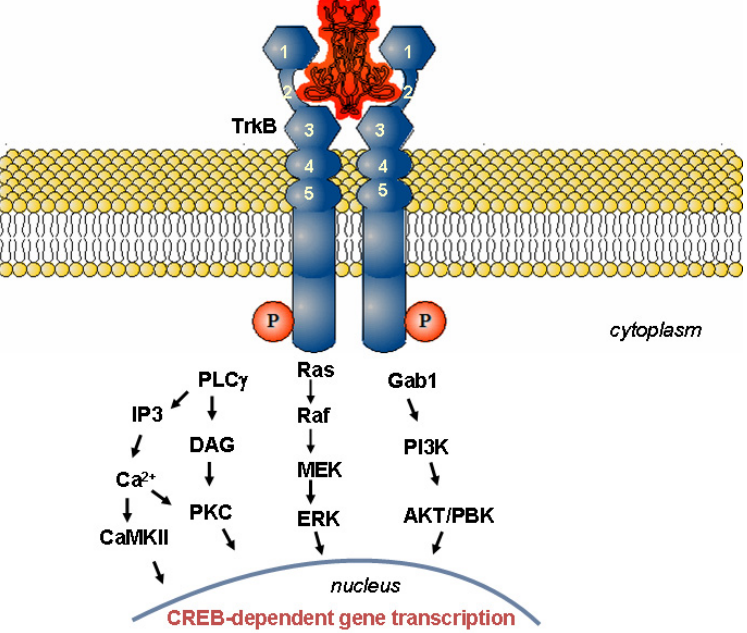
Figure 2. Schematic presentation of the BDNF-activated tropomyosin-related kinase B (TrkB) signal transduction. The neurotrophin binding to the TrkB receptor controls three major intracellular signaling pathways [77]. Receptor phosphorylation and activation of Ras results in activation of the mitogen-activated protein kinase (MAPK)-signaling cascade, which promotes neuronal differentiation, including neurite outgrowth and neurogenesis. Activation of phosphoinositol-3 kinase (PI3K)/protein kinase B (AKT) pathway, through Gab1, promotes survival and proliferation of neurons and other